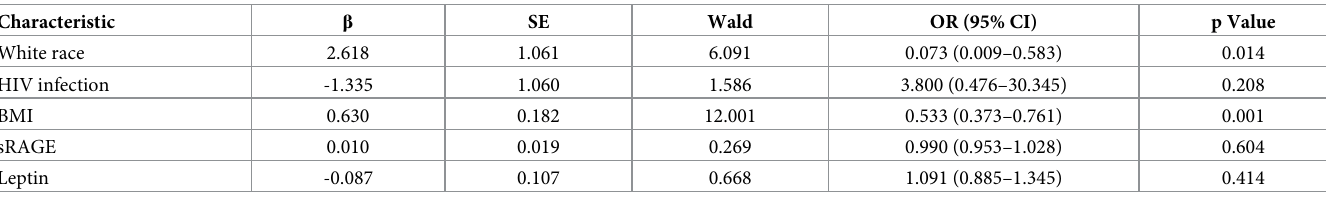
Table 3. Multivariable analysis of factors associated with case status.